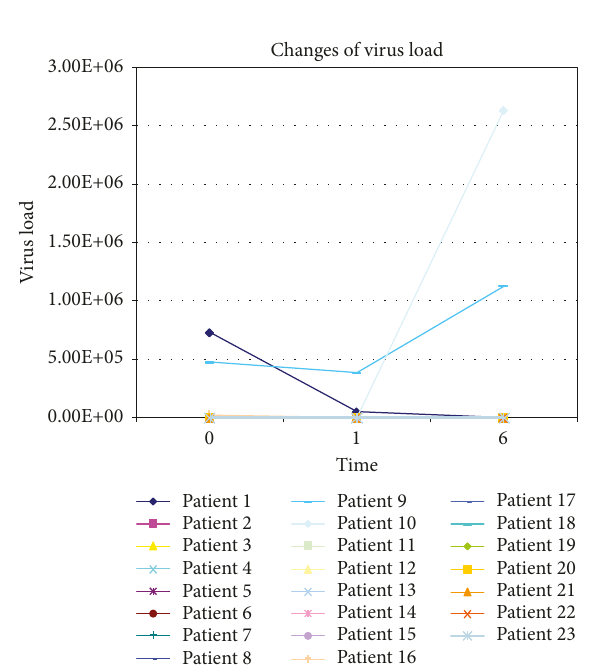
Figure 3: Changes of virus load of patients with decompensated liver cirrhosis caused by chronic hepatitis B and hepatitis C. Patient 9 was with hepatitis C. Patient 1 belonged to the control group, and patient 15 belonged to the AMBT group; the lamivudine had been replaced by entecavir before surgery. Patient 10 belonged to the AMBT group; the lamivudine had been replaced by entecavir in 6 months after surgery. The virus load of the rest of the patients is Figure 2. Further, 18 mL of autologous bone marrow in which the mean number of infused MSCs was 1183.75 ± 493.6 and the mean number of infused HSCs was 712362.5 ± 493434.14 was transfused in the patients of the ABMT group. The relative percentage of various BM cell populations is shown in Table 3. The isolated BMCs from all patients had a cell viability > 95%. All samples were neg- ative for endotoxin. Isolated MSCs were CD45 − , CD31 − , CD14 − , CD19 − , CD34 − , CD105 + , CD71 + , CD73 + , and CD90 + . Isolated HSCs were CD45 − and CD34 + .